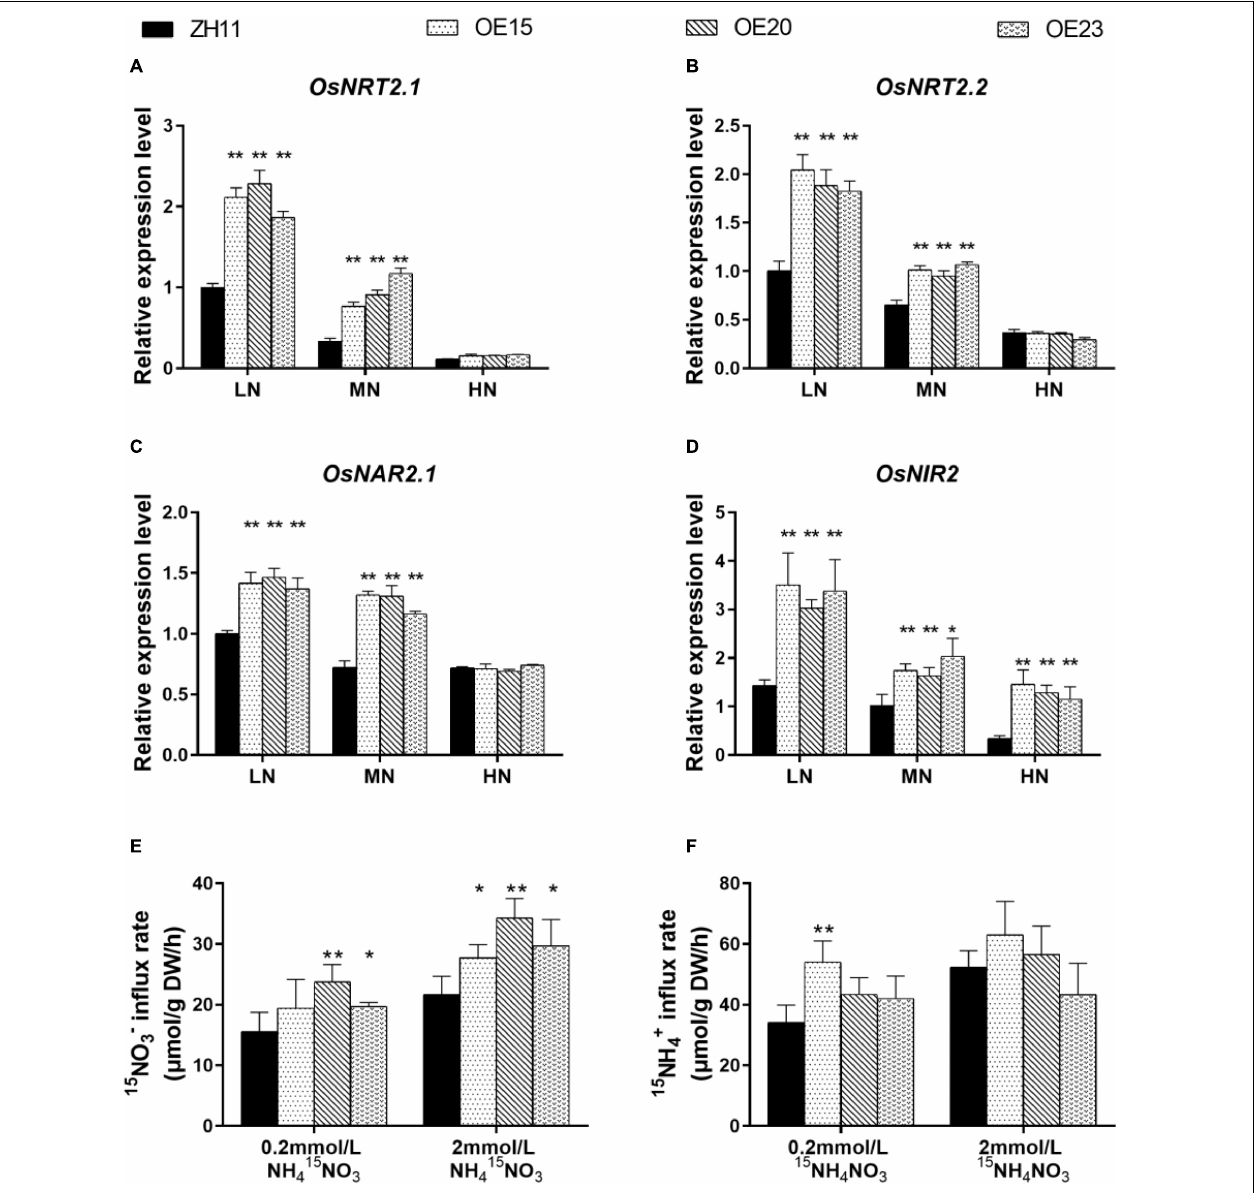
FIGURE 5 | The expression level of N related genes and 15 N uptake analysis. (A–D) The expression of OsNRT2.1 , OsNRT2.1 , OsNAR2.1, and OsNIR2 in the roots of OsMYB305 -OE lines (OE15, OE20, OE23) treating with various N level. (E,F) 15 N influx rates of the OsMYB305 -OE lines and WT (ZH11). The seedlings were grown in 0.2 or 2 mM NH 4 NO 3 for 2 weeks, and then transferred to the medium in which the N sources were replaced by equal concentration of 15 N labeled N sources for 10 min. NH 415 NO 3 : NO 3 - were labeled by 15 N; 15 NH 4 NO 3 : NH 4 + were labeled by 15 N. Data in (A–D) were means ± SD of 3 biological replications. Data in (E,F) were means ± SD of 4 biological replications. Statistical significance was determined by Student’s t -test (* P < 0.05, ** P <